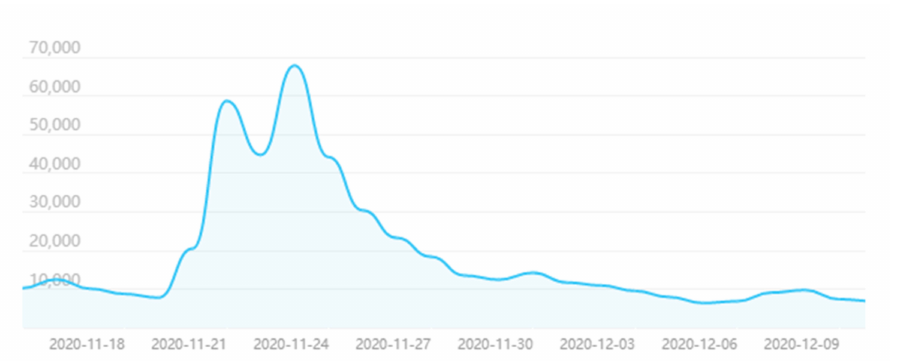
Figure 31. “Shanghai epidemic” Baidu